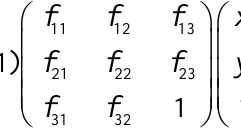
Figure. 4. Schematic diagram of solving the problem of determining the robot trajectory using two stereo